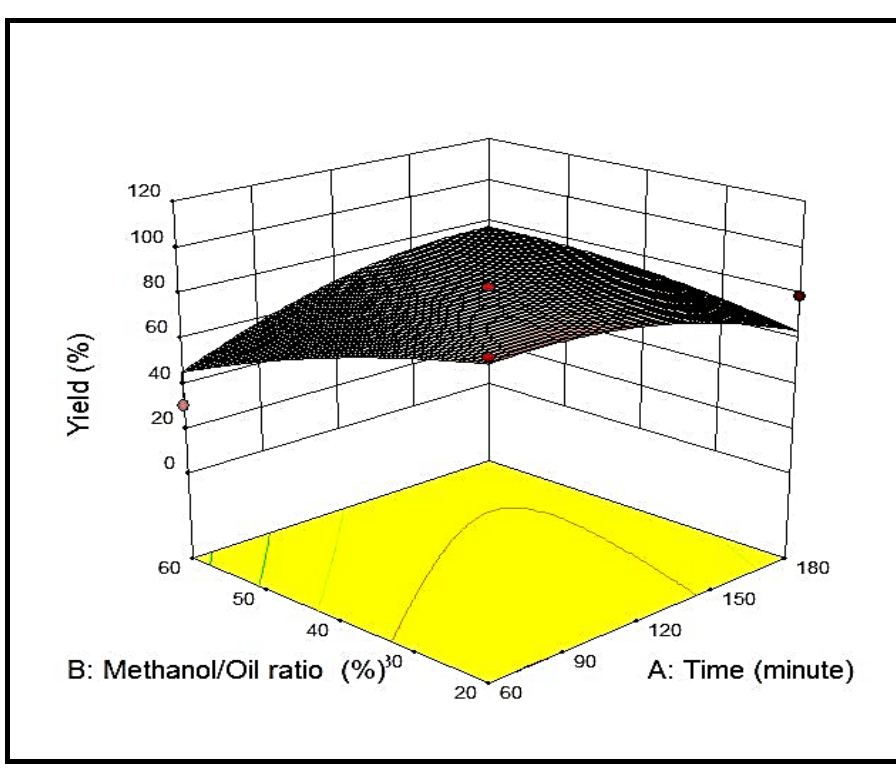
Figure 4. Biodiesel yield (%) vs. methanol/oil ratio (%) and Rt (min).